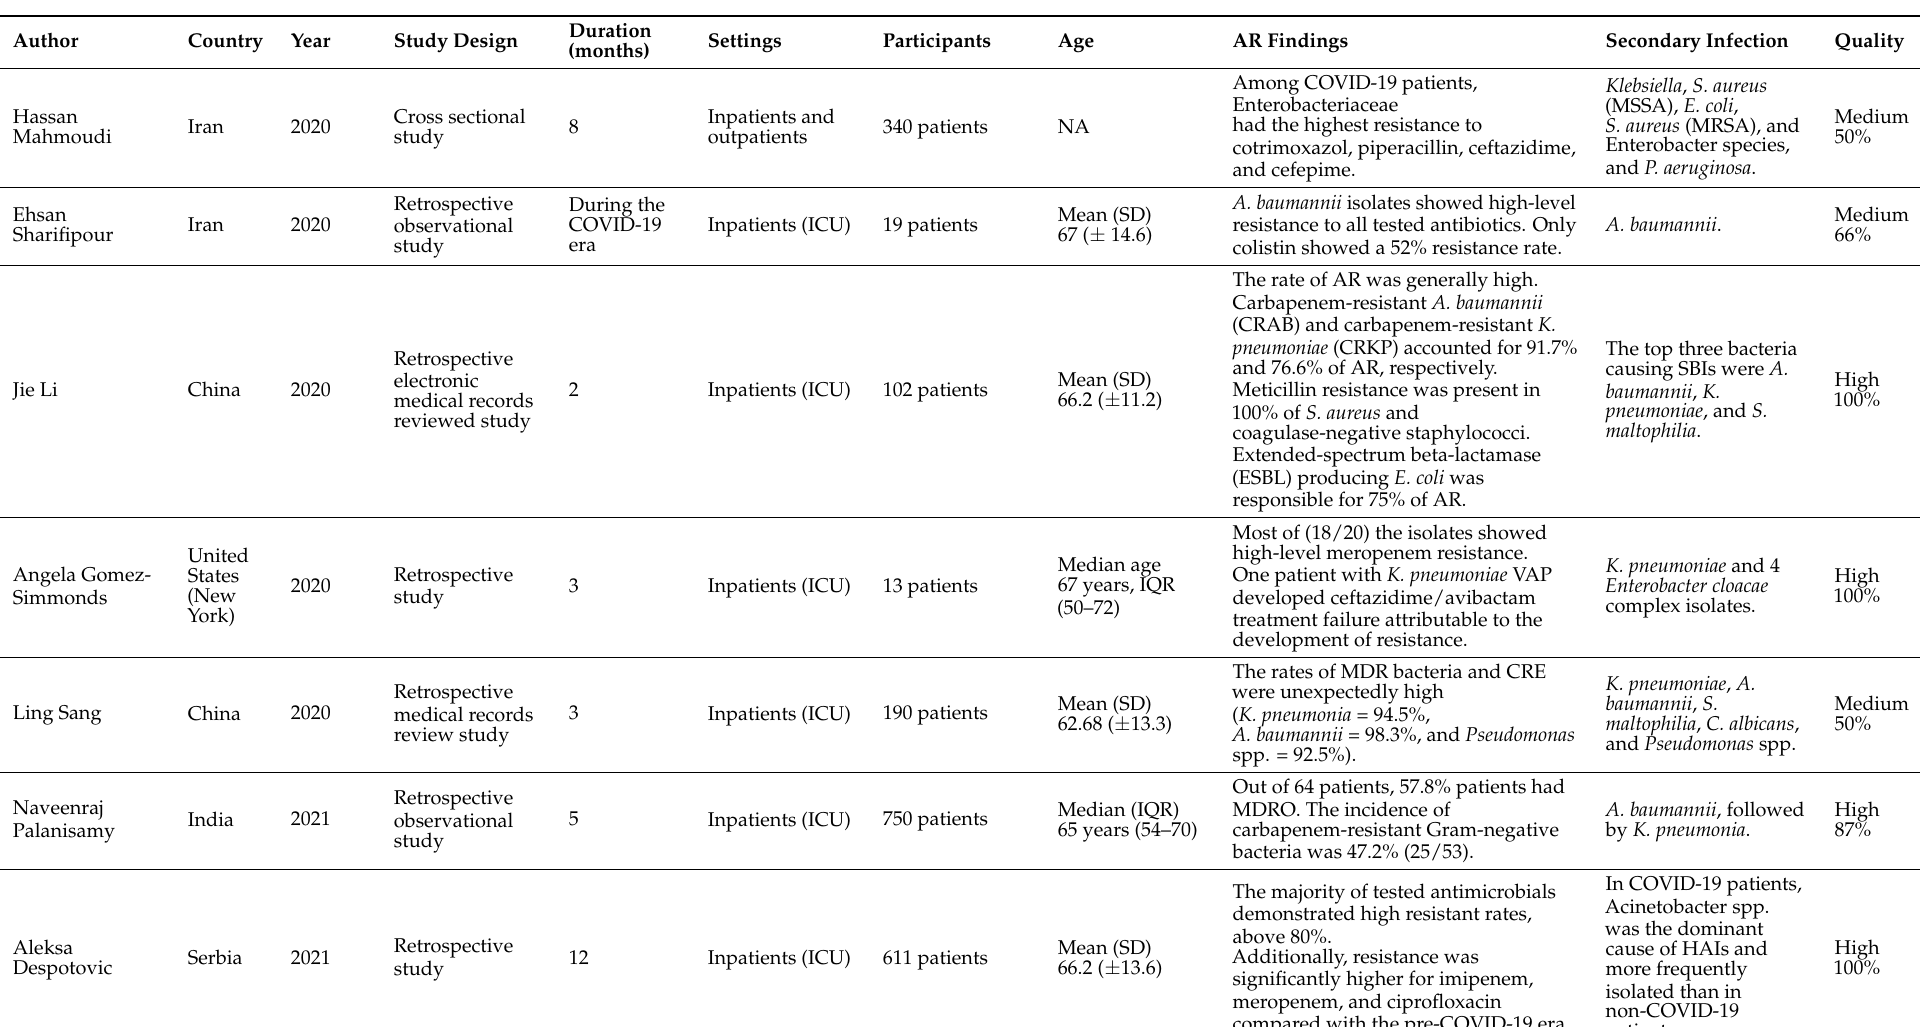
Table 1. Summary of characteristics and findings of the 23 studies